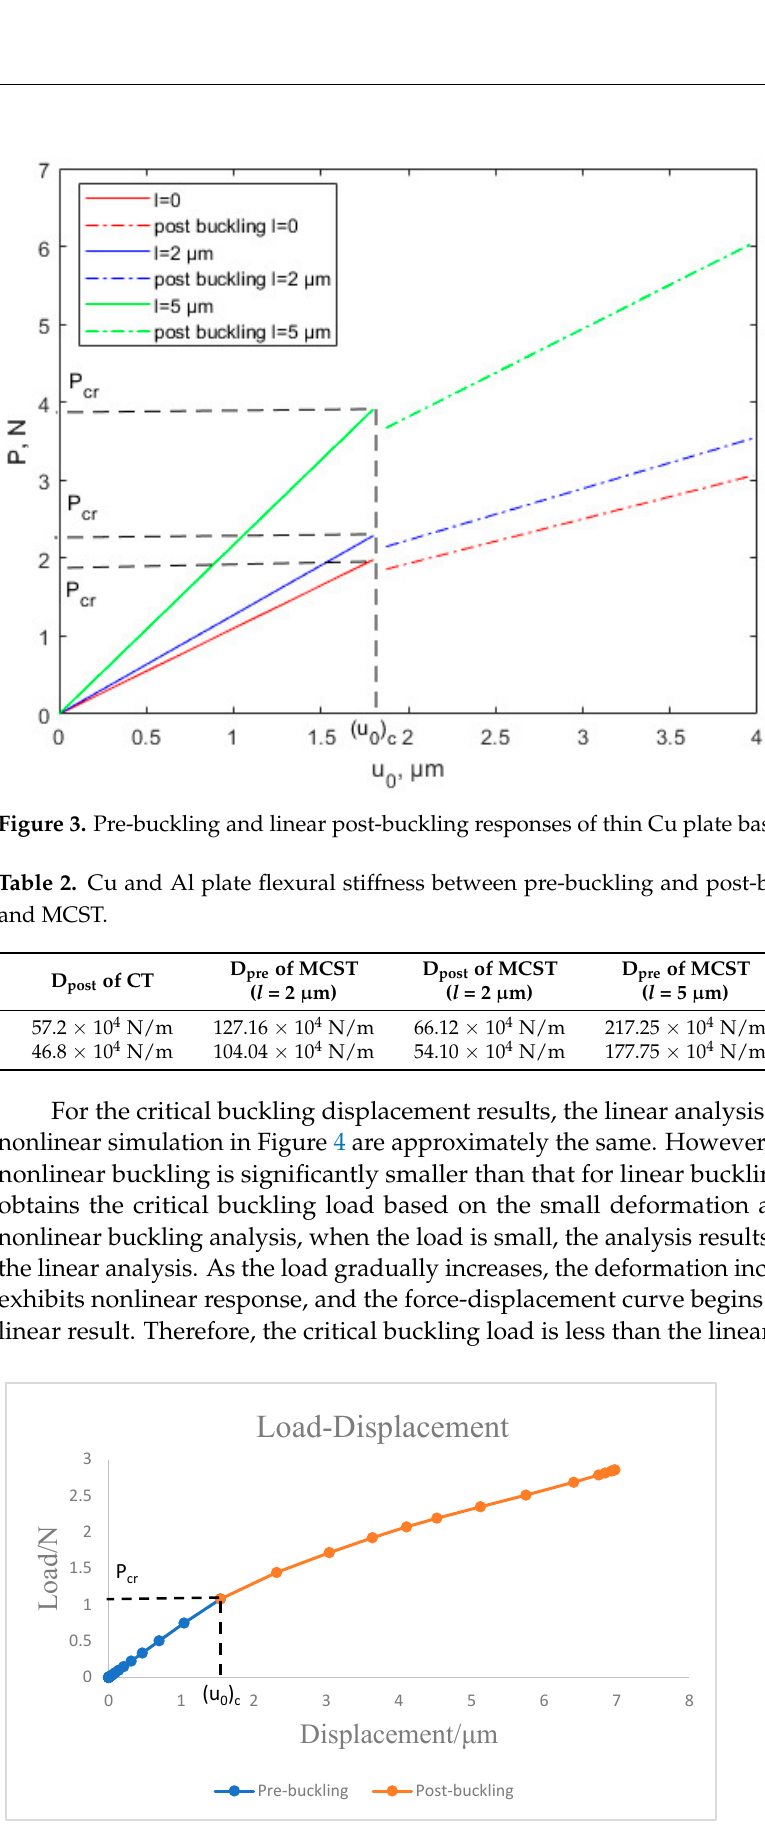
Figure 4. Nonlinear buckling response simulation of Cu plates.